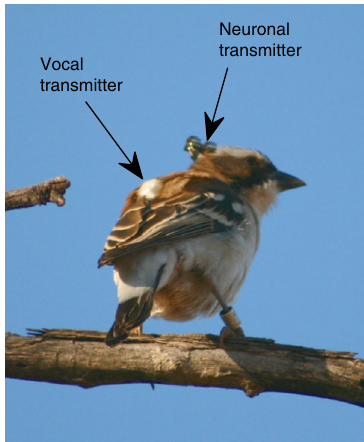
Fig. 1 Experimental animal species. Free-living male white-browed sparrow- weaver ( P . mahali ) perching in a tree in the South African Kalahari. The bird carries a vocal and a neuronal (see below) radio telemetric